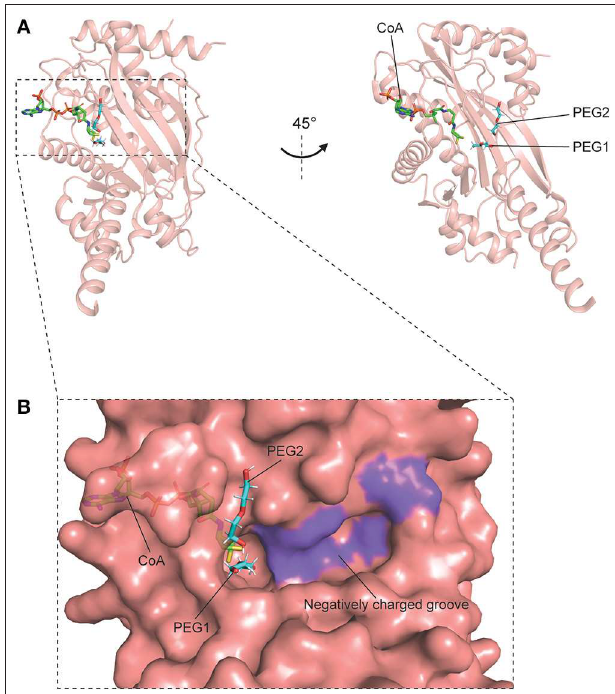
FIGURE 4 | Crystal structure of p300 catalytic domain in complex with CoA, containing PEG1 and PEG2 (PDB code: 4PZR ). p300 is shown in pink, CoA is shown as green sticks, and the PEG moieties are shown as cyan sticks. (A) Overall structure of p300–CoA catalytic domain comprising a central β -sheet and α -helices around it. (B) Surface of the catalytic site and the region surrounding it. The shallow, negatively charged groove composed of Ser1396, Tyr1397, Thr1357, and Asp1625 is colored in